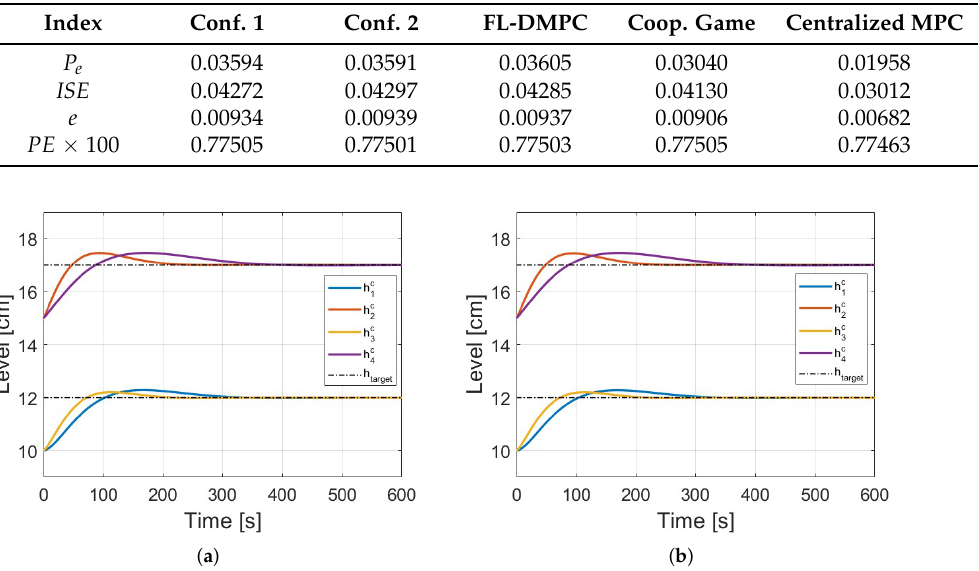
Table 3. Case 1: Configurations performance through performance indices values.